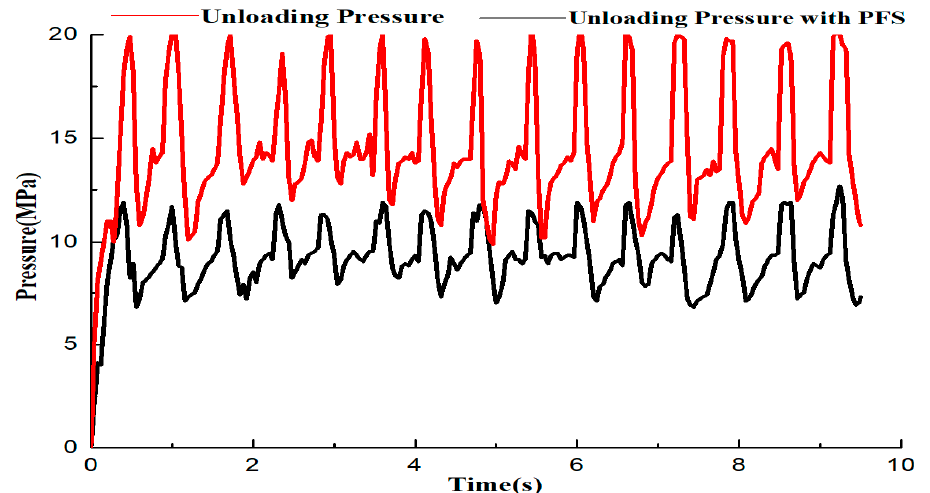
Figure 9. Unloading pressure of the hydraulic press with the energy ‐ saving system and the traditional hydraulic press during fast hydraulic press during fast forging.